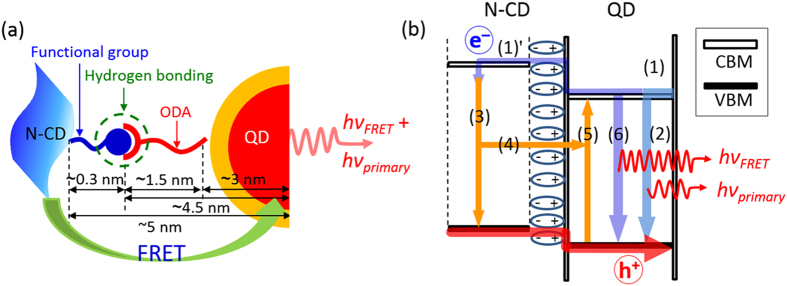
FRET from N-CD to QD.(a) Schematic illustration depicting the interfacial structure of QD/N-CD where the FRET occurred. (b) The FRET-enhanced EL process in the electronic structure of QD/N-CD heterojunction. (1) charge transport; (2) primary EL emission by exciton recombination in QDs; (1)′ electron overflow to N-CD layer; (3) non-radiative recombination; (4) FRET; (5) FRET-driven excitation and (6) EL emission.